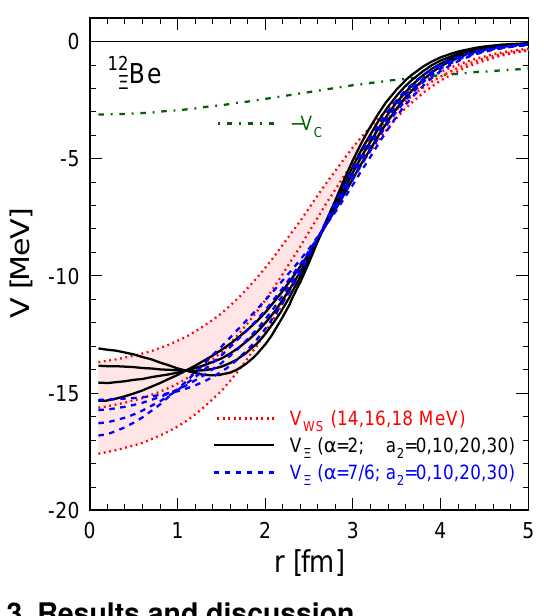
Figure 1. Local Ξ − mean field V Ξ and V C in 12 Be, obtained Coulomb field Ξ − with the SHF models with various forces in Table 1. Increasing values of a 2 produce deeper well depths V Ξ (0). The Woods-Saxon mean field deduced in [15] is shown for